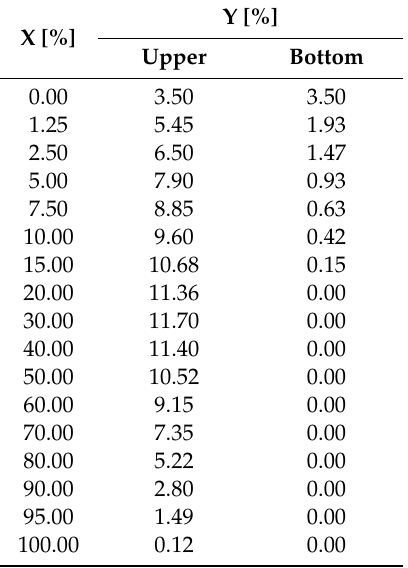
Figure 5. Cross-section, lift, and drag coefficients of a Clark Y airfoil ( a ) Cross section of Clark-Y, ( b ) Clark-Y lift and drag coefficient [12]. Table 1. Data describing a Clark Y airfoil [12].